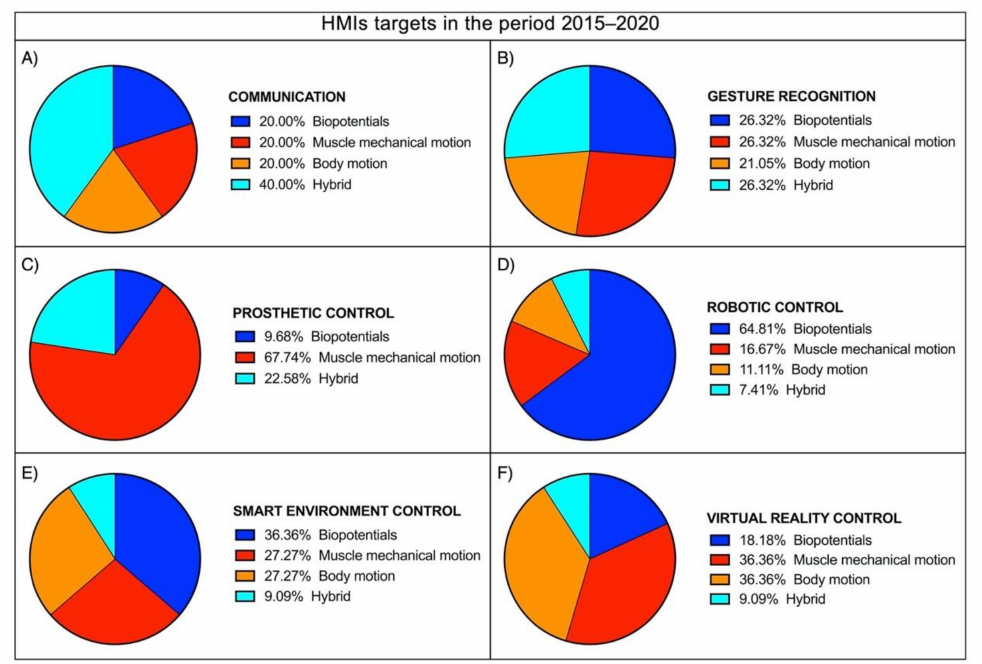
Figure 6. Pie charts illustrating the percentage distributions of the HMIs targets in the period 2015–2020: ( A ) Communication; ( B ) Gesture recognition; ( C ) Prosthetic control; ( D ) Robotic control; ( E ) Smart environment control; ( F ) Virtual reality